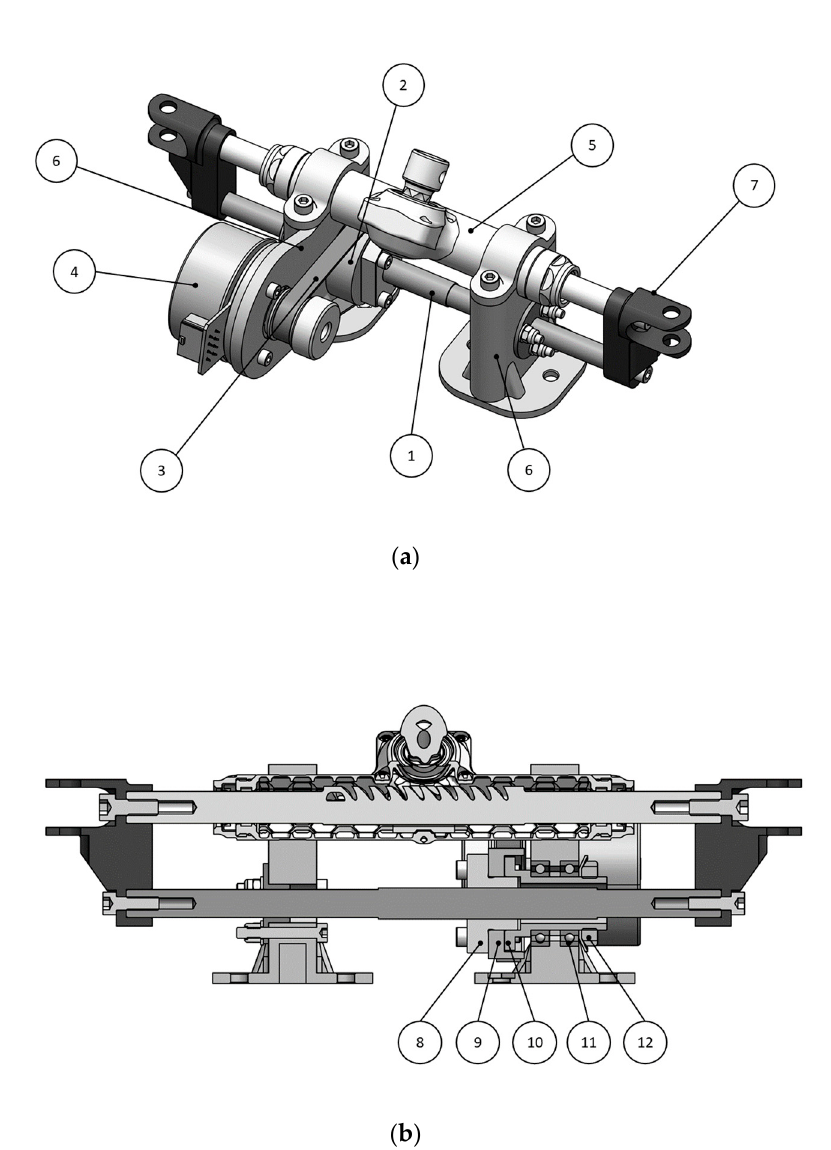
Figure 1. ( a ) Autonomous Steering System actuator view: 1—Ball screw; 2—Ball screw nut and bearing assembly; 3—HTD belt; 4—BLDC motor; 5—Steering rack; 6—Support structure; 7—Clevises. ( b ) Autonomous Steering System cross-section to highlight the ball screw nut and bearing assembly: 8—Ball screw nut; 9—HTD pulley; 10—Nut bearing support; 11—Ball bearings; 12—Lock nut washer.